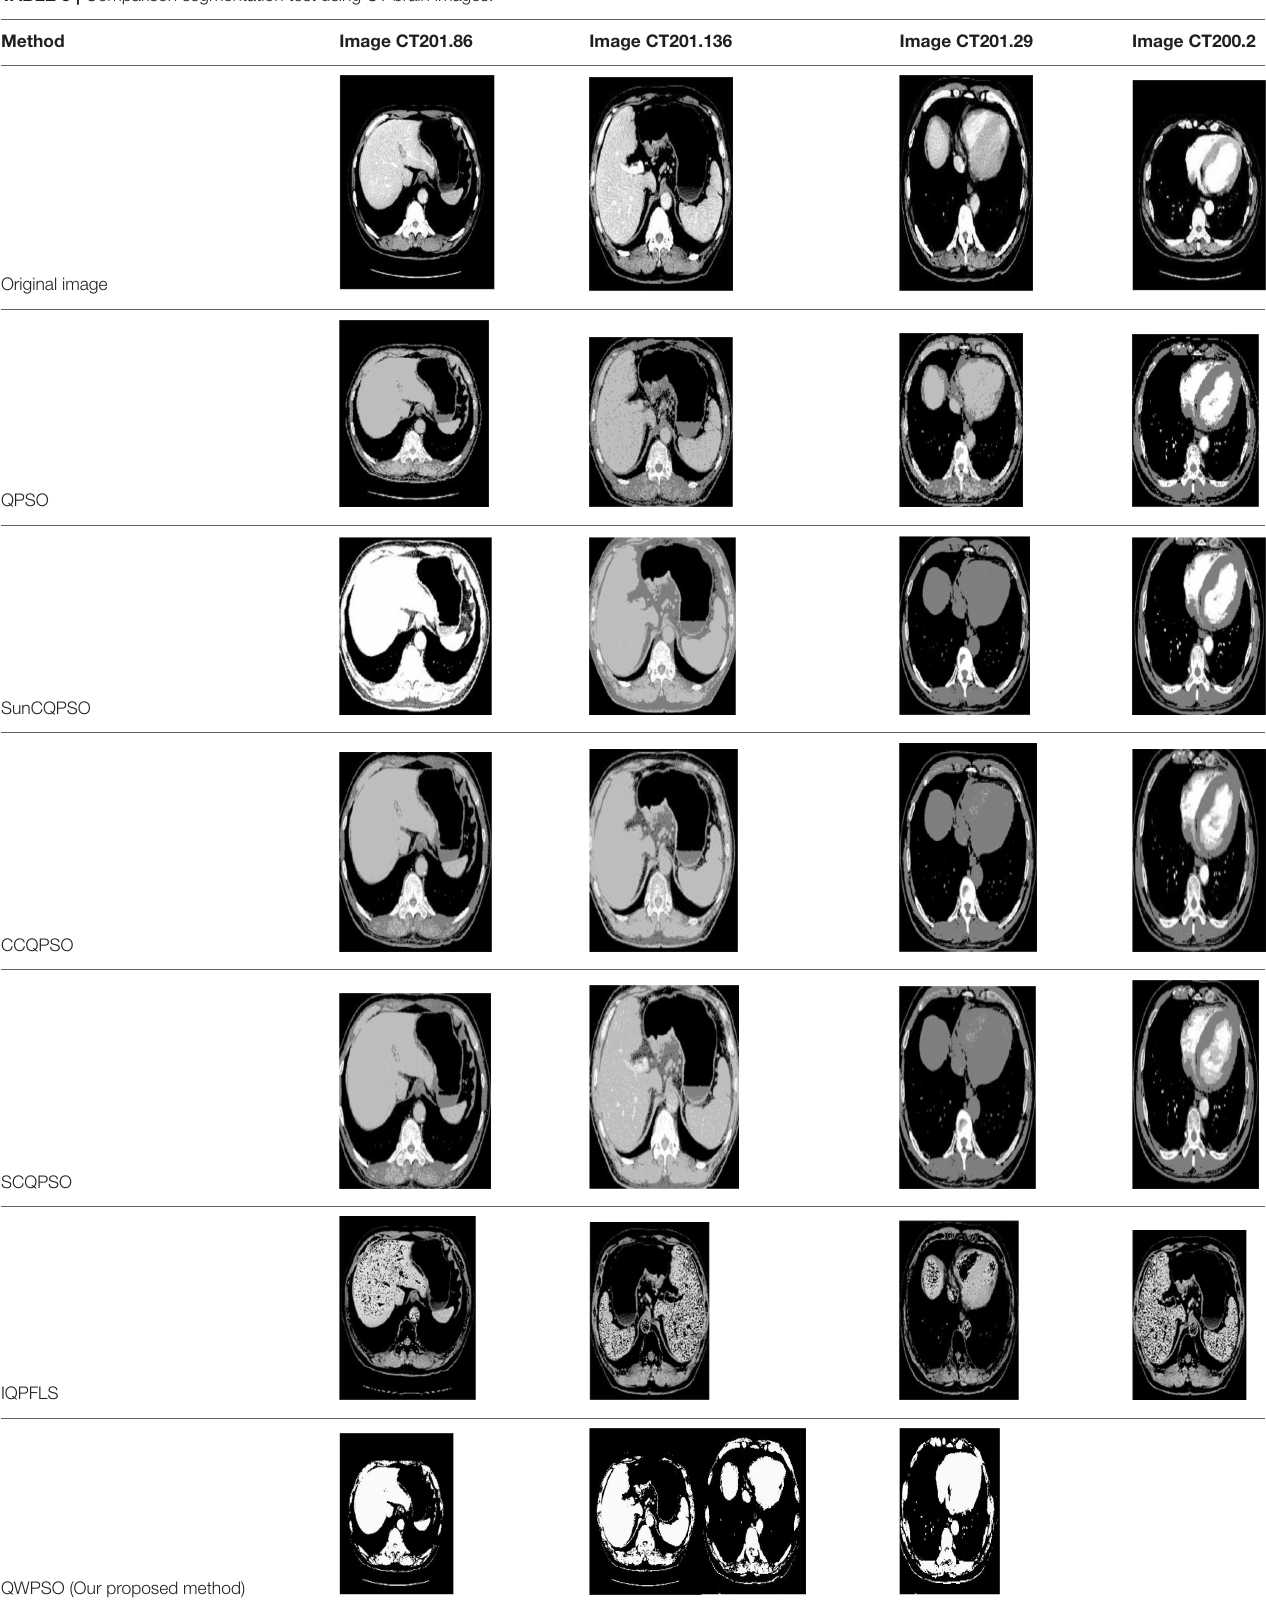
TABLE 3 | Comparison segmentation test using CT brain